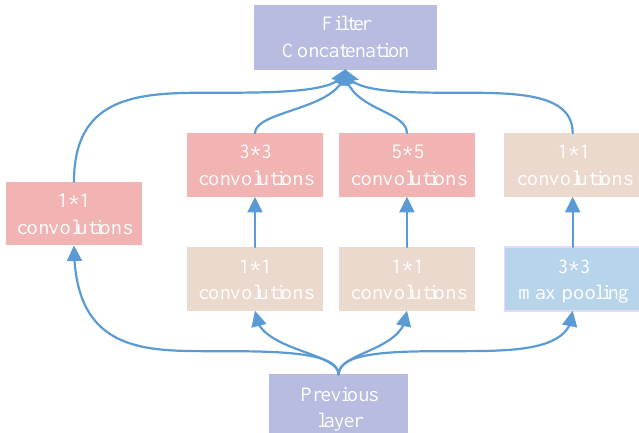
Figure 1. The Architecture of Inception